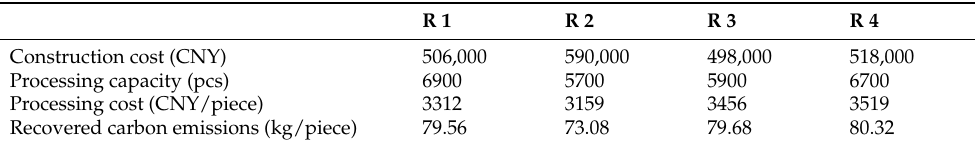
Table A11. Details of various costs, treatment capacities, and unit carbon emissions of the recovery center R.